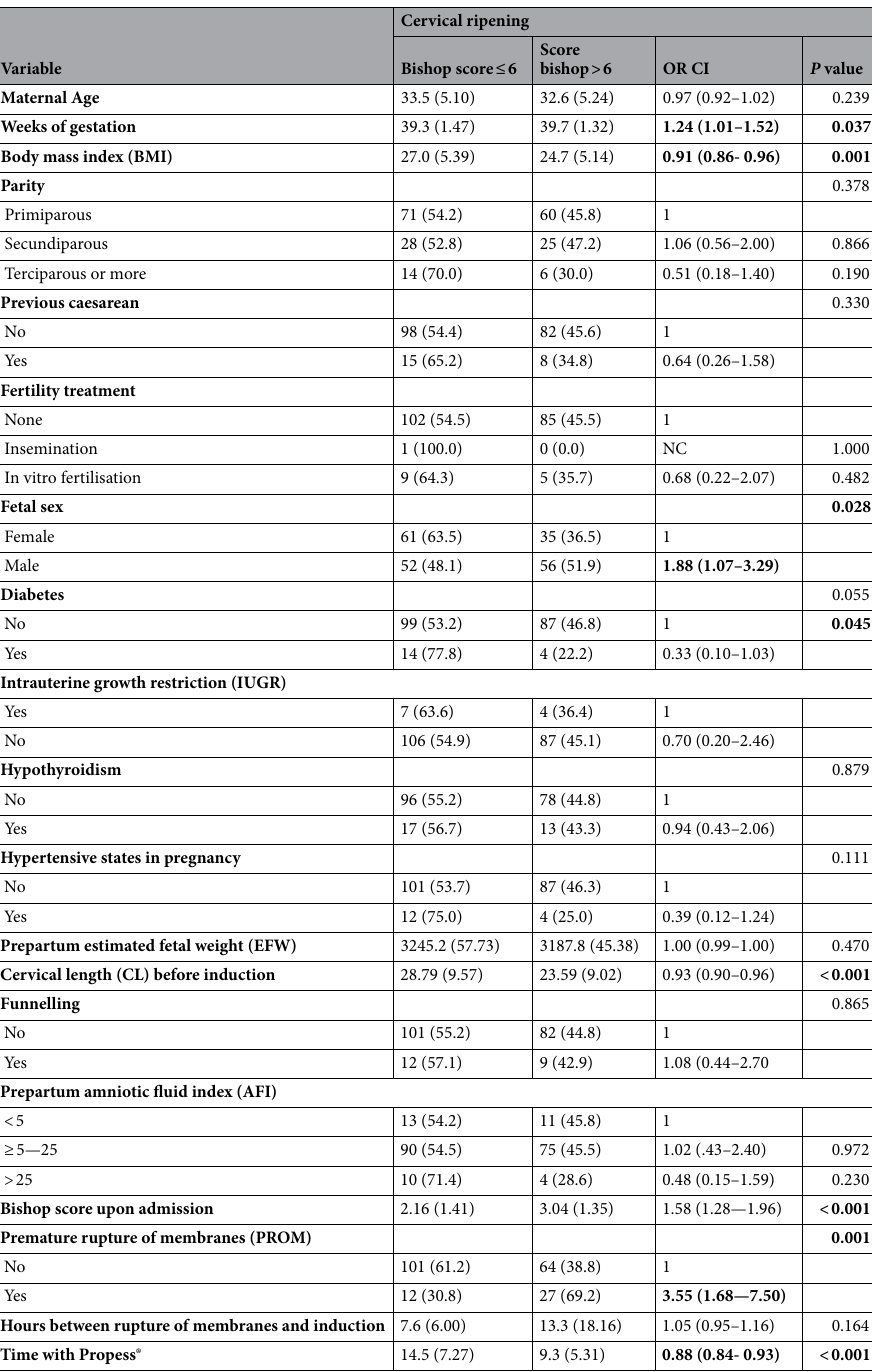
Table 2. Bivariate analysis of the obstetric characteristics and effective cervical ripening. Significant values are in